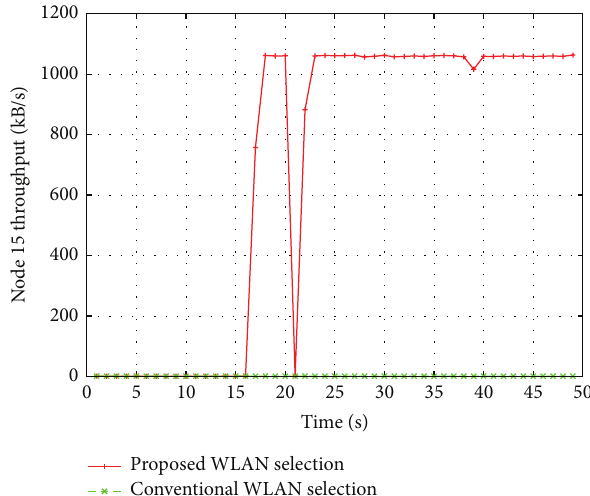
Figure 6: WiMAX BS2 (Node 6) throughput.